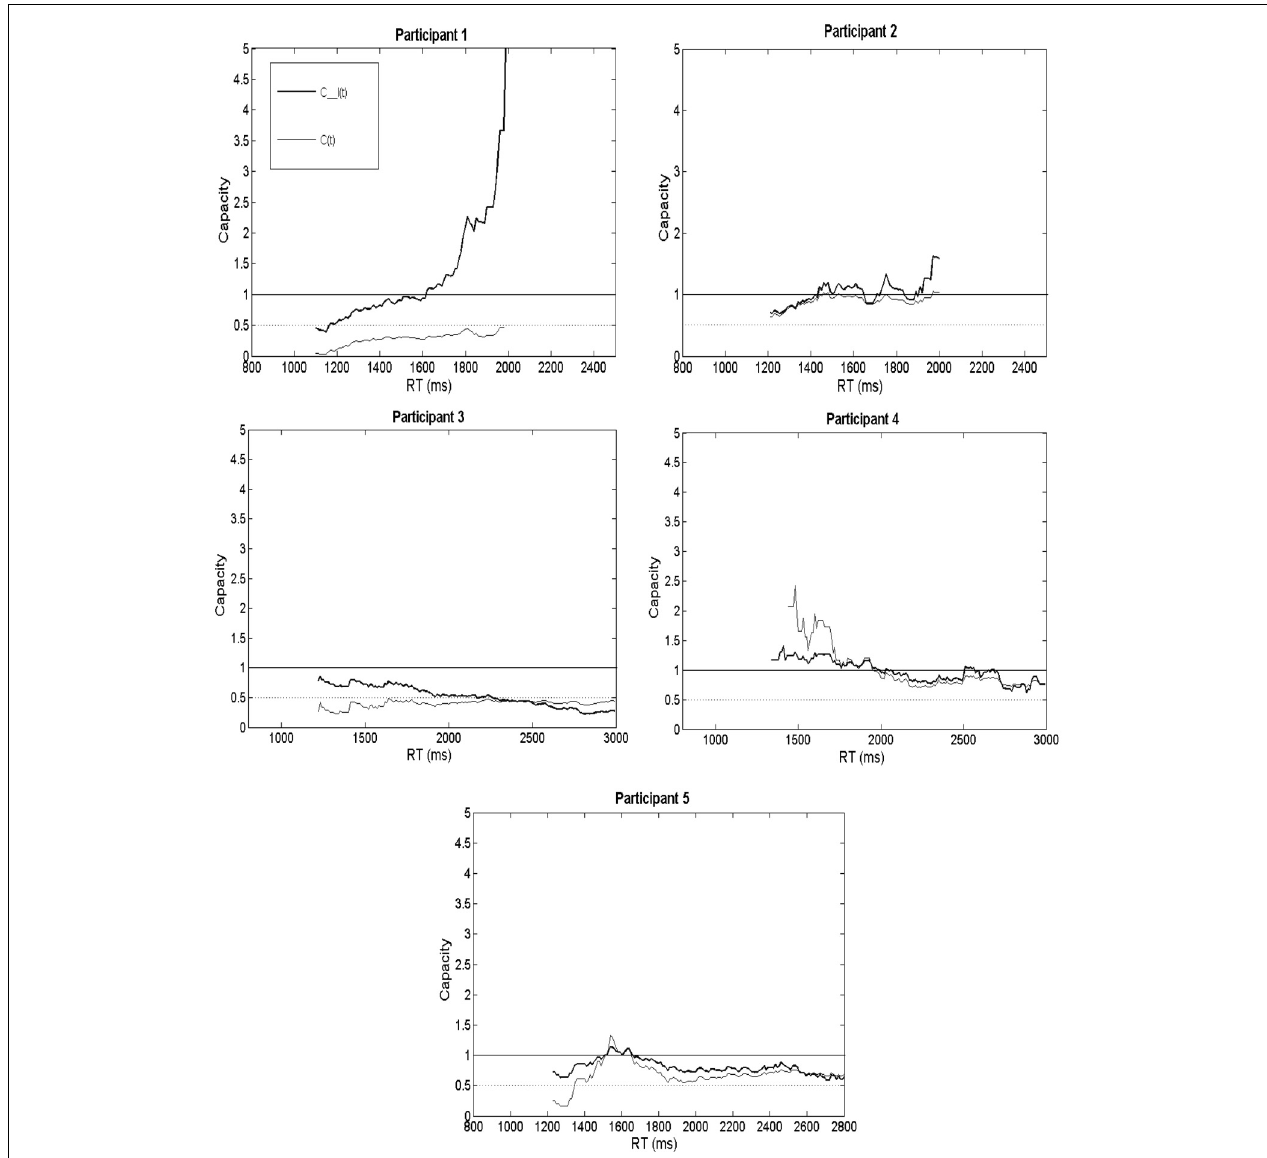
FIGURE 3 | Capacity ( C(t) and C_I(t) ) plotted individually for each of the five